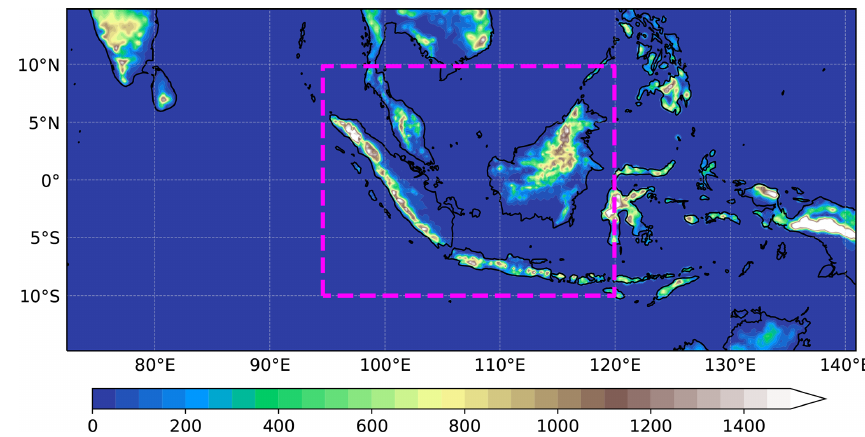
Figure 4. Terrain height (m) within the outer simulation domain, which is outlined by the map. The inner domain is outlined by the magenta